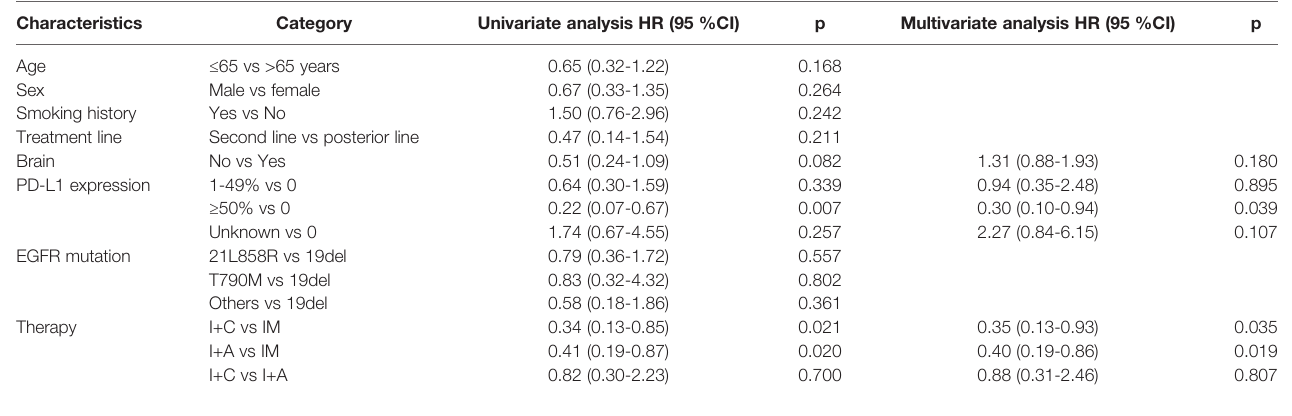
TABLE 3 | Univariate and multivariable analyses for covariables associated with overall survival.